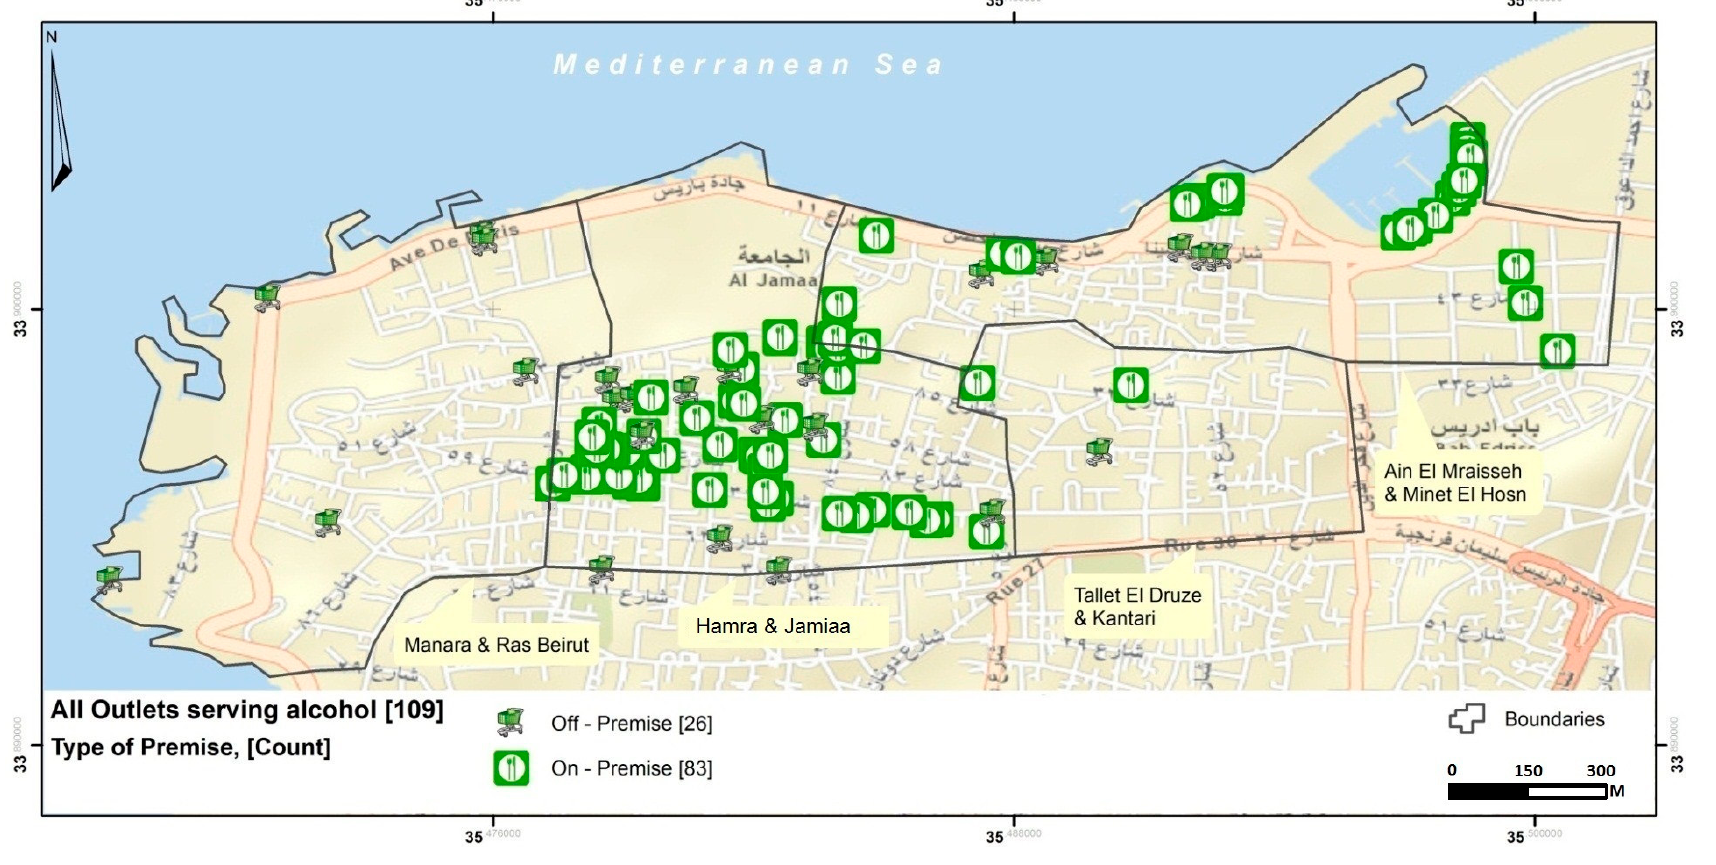
Figure 3. On-premise and off-premise alcohol outlets in Beirut district.